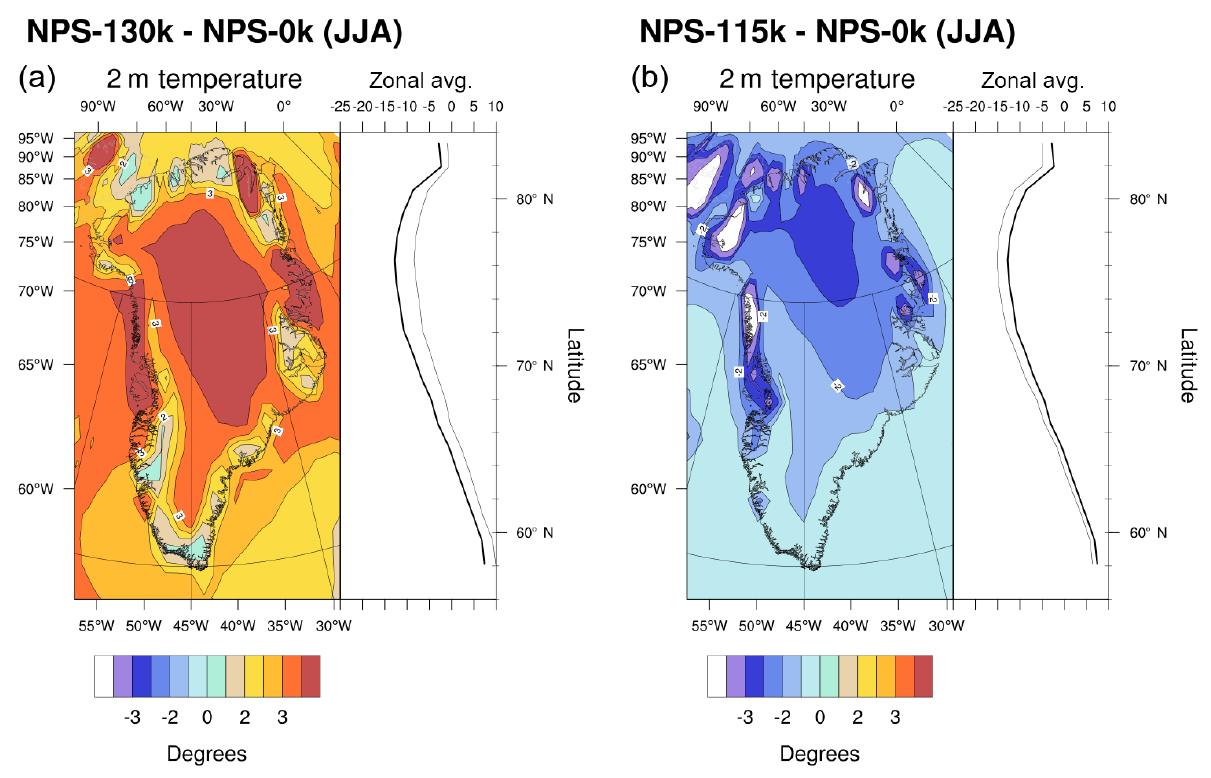
Figure 7. Summer (JJA) 2m temperature anomalies for 130ka (a) and 115ka (b) from preindustrial conditions. In both plots, the left and right subplots, respectively, represent the spatial pattern of anomalies and their zonal